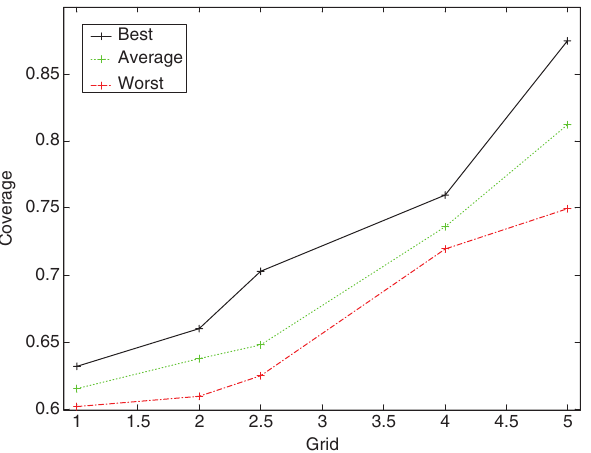
Figure 12: The Line Chart of the Coverage Rate with the Raster Size Changing.